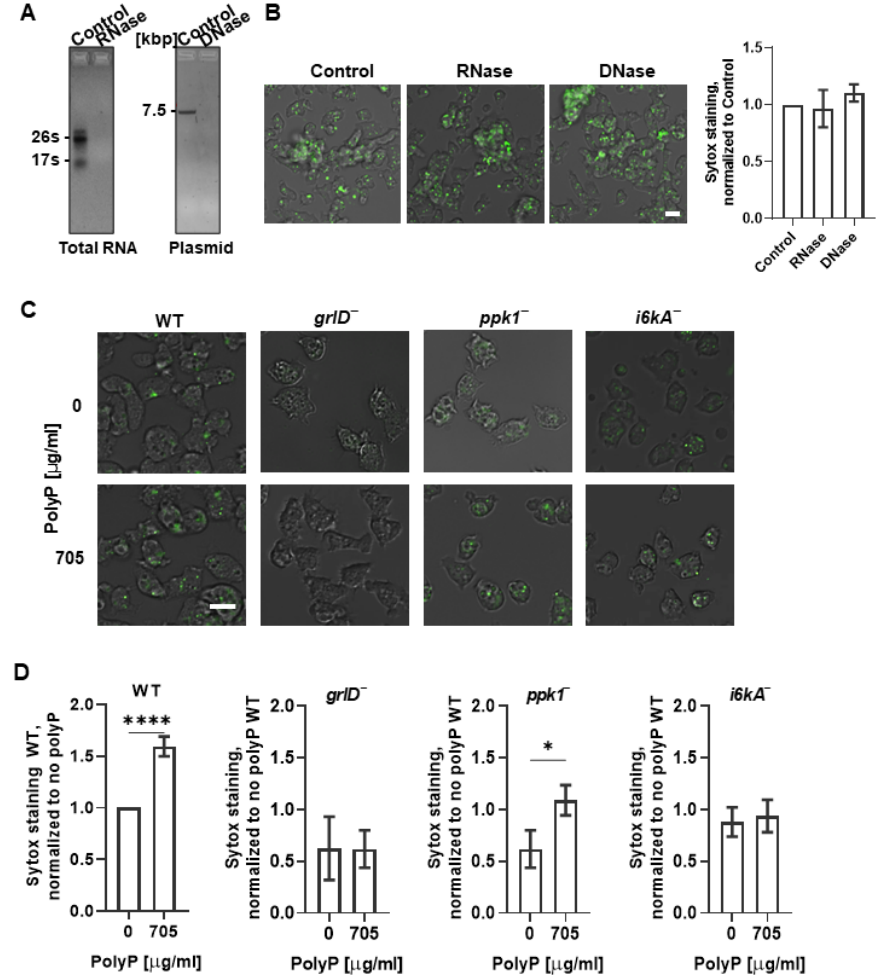
Figure 2. Starving D. discoideum cells require GrlD and I6kA to bind exogenous polyP. ( A ) Agarose gels of total RNA or plasmid DNA untreated (Control) or treated with RNase or DNase, respectively, stained